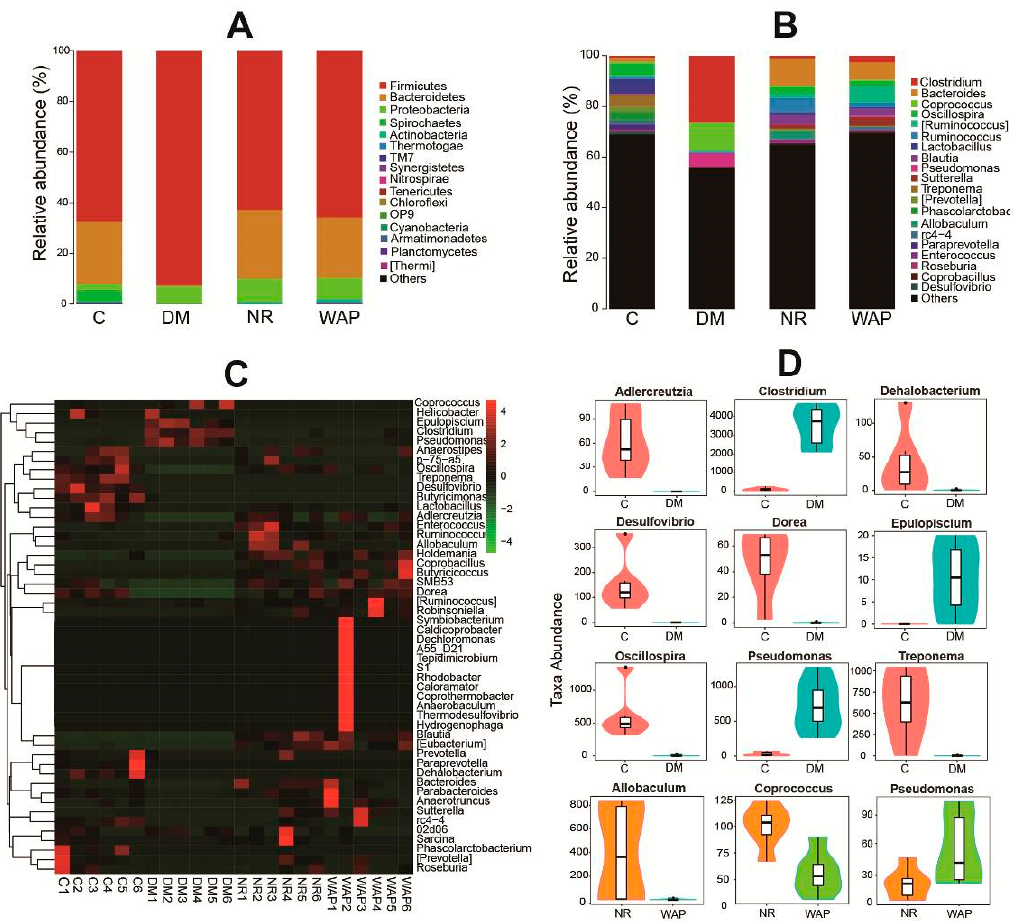
Figure 5. WAP altered the gut microbiota composition. ( A ) phyla level, ( B ) genus level, ( C ) heat map, ( D ) comparison between groups C and DM, and groups NR and WAP at the genus level. C, control group; DM, antibiotic-associated diarrhea group; NR, natural recovery group; and WAP, Astragalus polysaccharides group. Table 2. The relative abundance of gut microbiota at the phylum level. Group Relative Abundance (%)